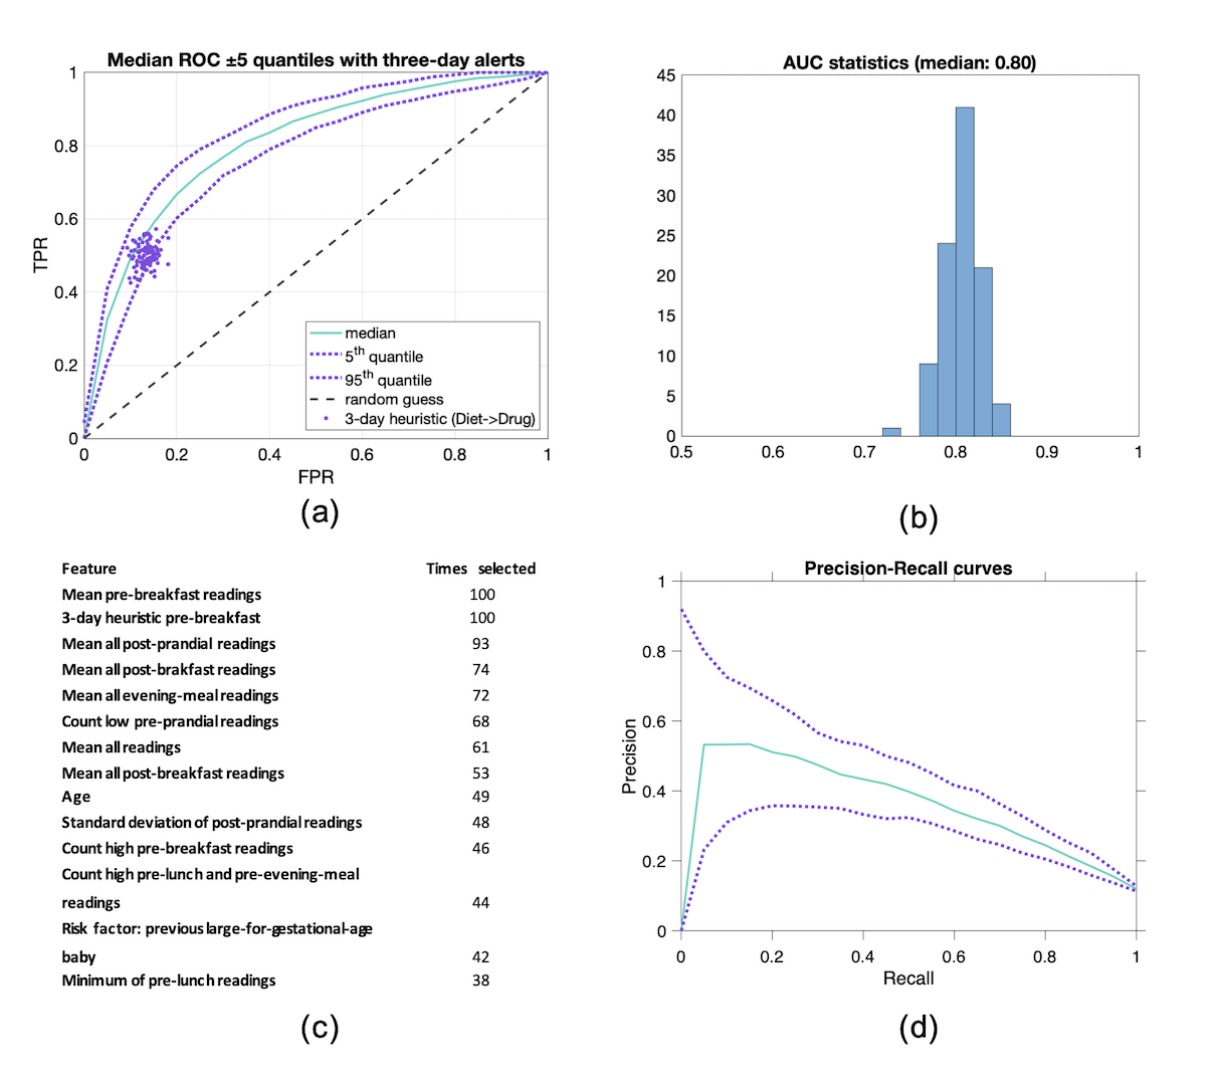
Figure 6. Experimental results. (a) ROC curves depicting the 5th and 95th centiles out of 100 repetitions of the classification experiment. (b) Histogram showing the distribution of area under the curve values for all 100 experiments. (c) Top 10 variables out of 100 repeated experiments. (d) Precision-recall curve depicting the 5th and 95th centiles out of 100 repetitions of the classification experiment. (a) Performance of the 3-day heuristic. Each dot represents a different run out of 100 repetitions. Although straightforward to implement, the average performance of the heuristic does not provide the possibility of customizing the algorithm to specific needs, such as increasing the true-positive rate at the expense of a higher false-positive rate. AUC: area under the curve; ROC: receiver operating